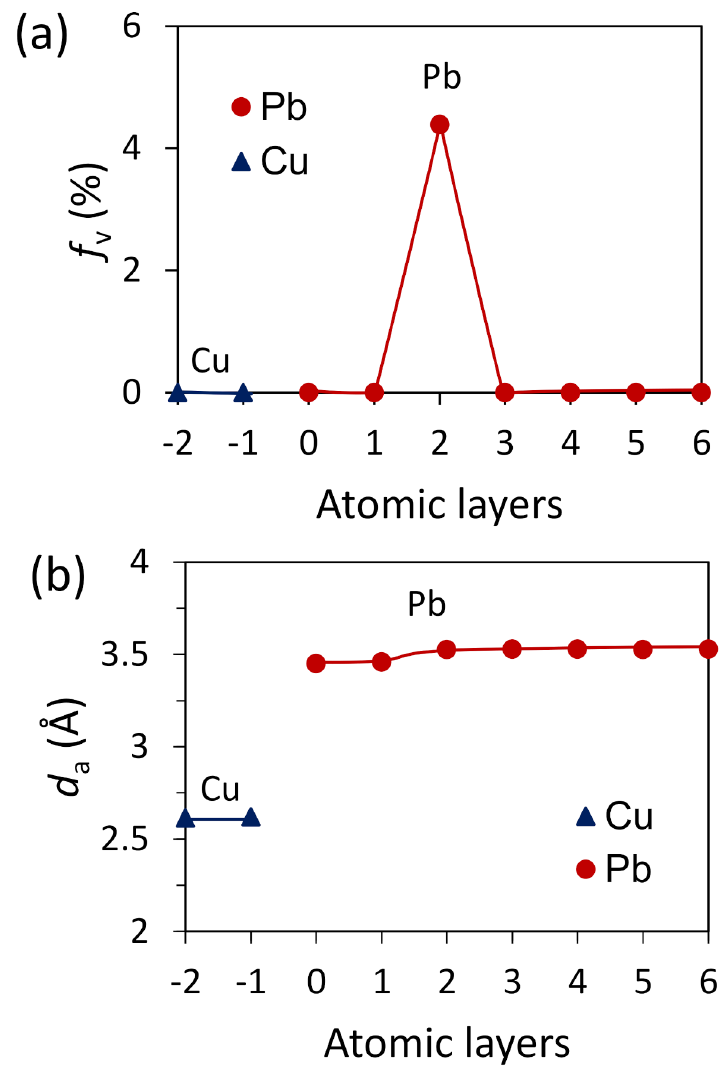
Figure 16. Atomic arrangement in solidified systems with large misfit [39]. The simulation system: Pb( l )/Cu( s ); T n = 594 K; and t = 1 ns. ( a ) Vacancy concentration, f v , and ( b ) average in-plane